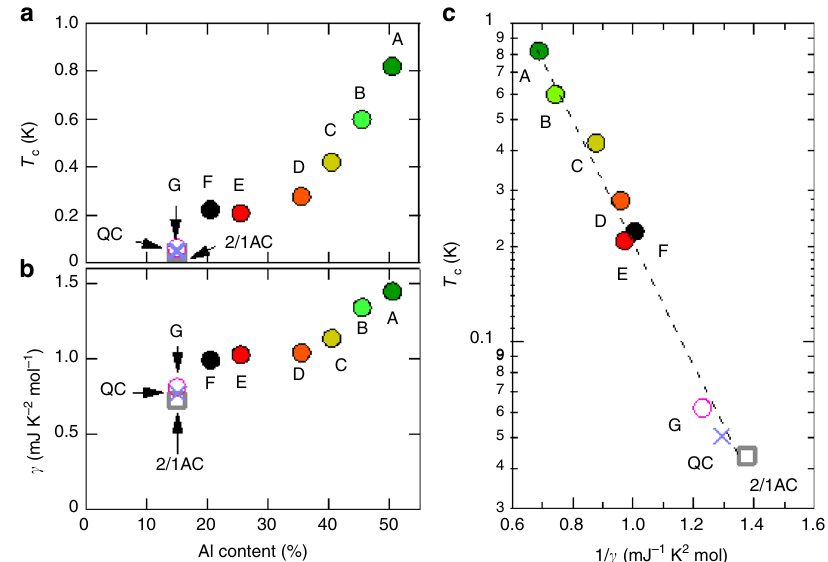
Fig. 6 Relation between transition temperature and γ coef fi cient. a Superconducting transition temperature T c as a function of Al content. Note that T c shows the sharp drop at Al content of about 15% corresponding to the QC and the 2/1AC. b Electronicspeci fi c heat coef fi cient γ as a function of Al content. The slight drop at 15% Al content suggests the pseudogap formation. c Correlation between T c and 1 = γ . The straight line denotes the interrelationship, ln T c / 1 = γ , marking the constant pairing interaction